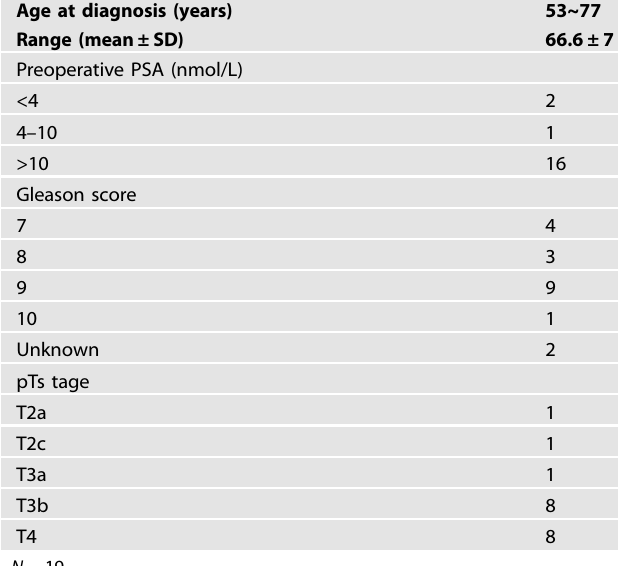
Table 1. Clinical features of prostate cancer patient